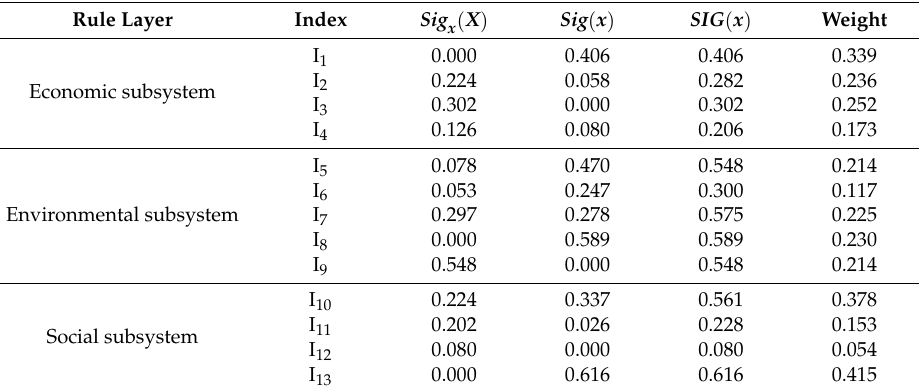
Table 6. The weight calculation results of index